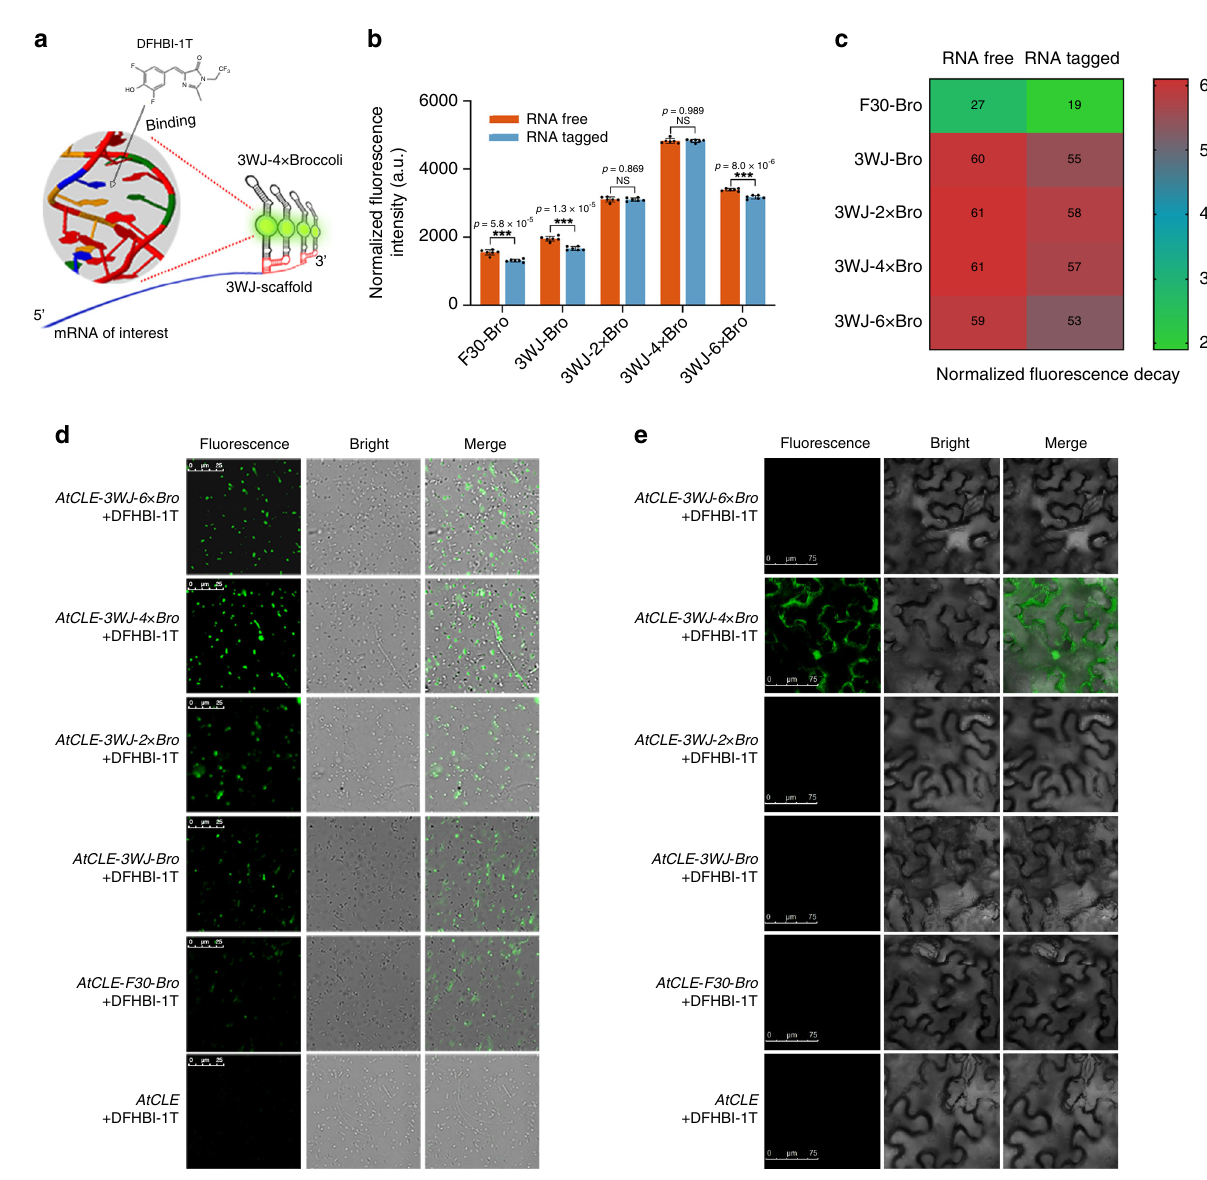
Fig. 2 Comparison of 3WJ-nBro series for imaging mRNA in vitro and in vivo. a Schematic view of mRNA imaging by 3WJ-nBro series. b Fluorescence changes of 3WJ-nBro series after appending to the 3 ′ end of AtCLE mRNA. Error bars depict the mean ± s.d. ( n = 6) and p values are calculated using an unpaired, two-tailed, Student ’ s t test. *** p < 0.001. NS, for not signi fi cant. c Differential fl uorescence decay of 3WJ-nBro series with and without AtCLE mRNA ( n = 6). d Representative fl uorescence images of 500 E. coli BL21 cells expressing 3WJ-nBro-tagged AtCLE mRNAs after incubation with 10 μ M DFHBI-1T. Scale bars, 25 μ m. e Fluorescence images of N. benthamiana leaf cells expressing 3WJ-nBro-tagged AtCLE mRNAs after incubation with 10 μ